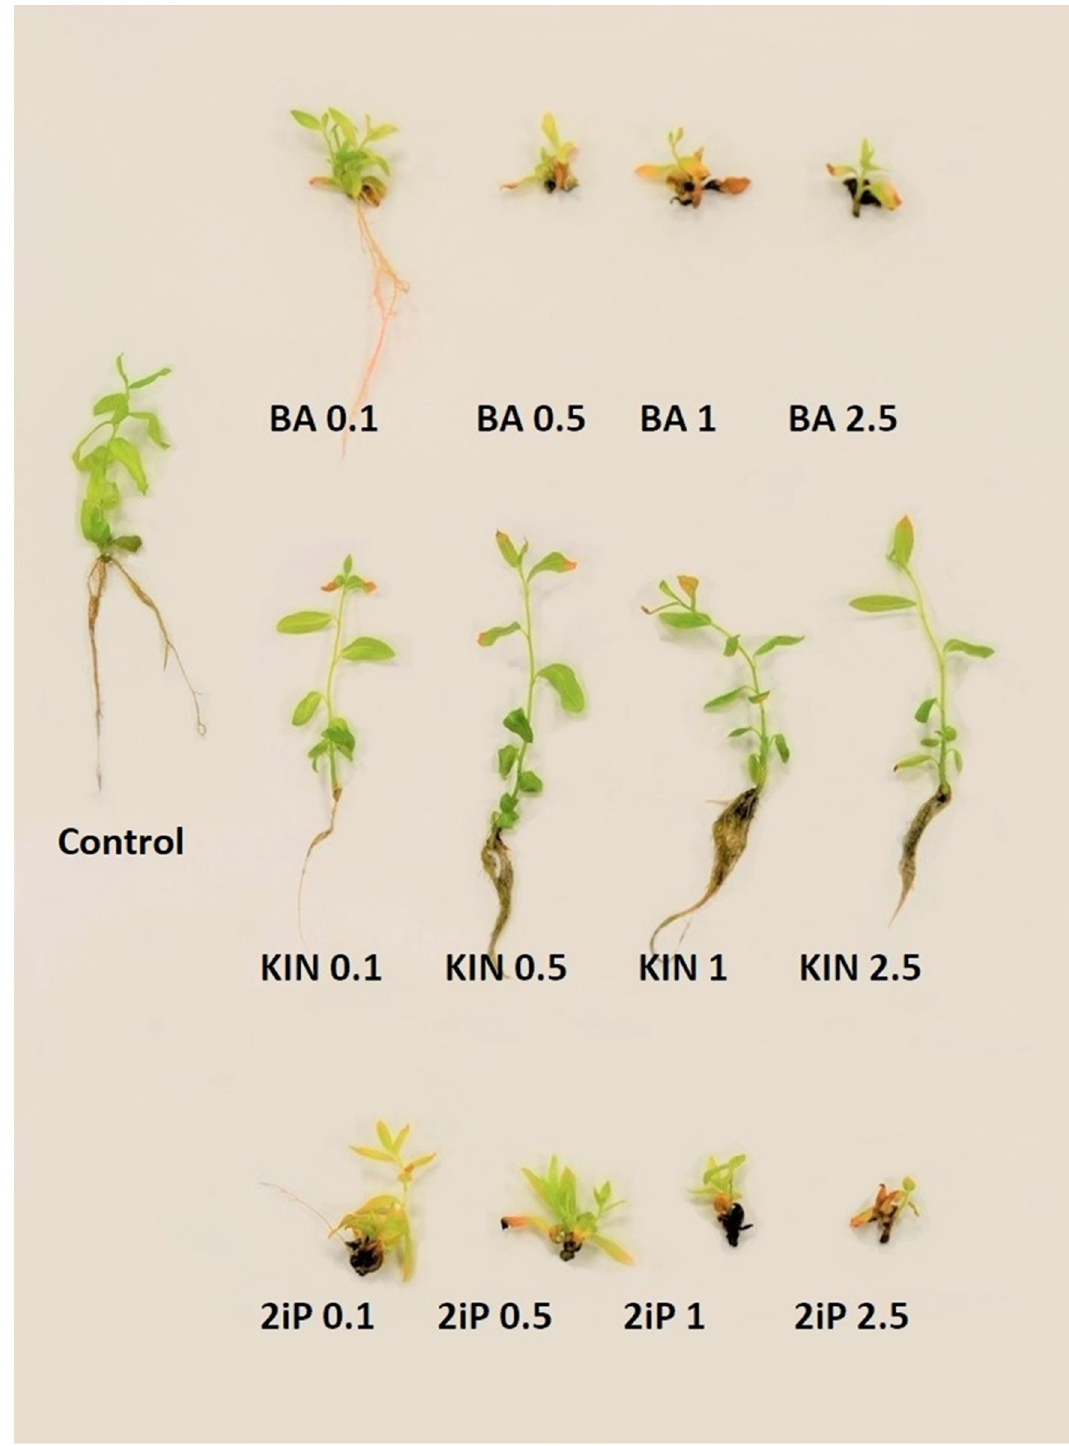
Figure 2. The representative S. myrtilloides shoots cultivated in vitro in the media supplemented with different cytokinins.